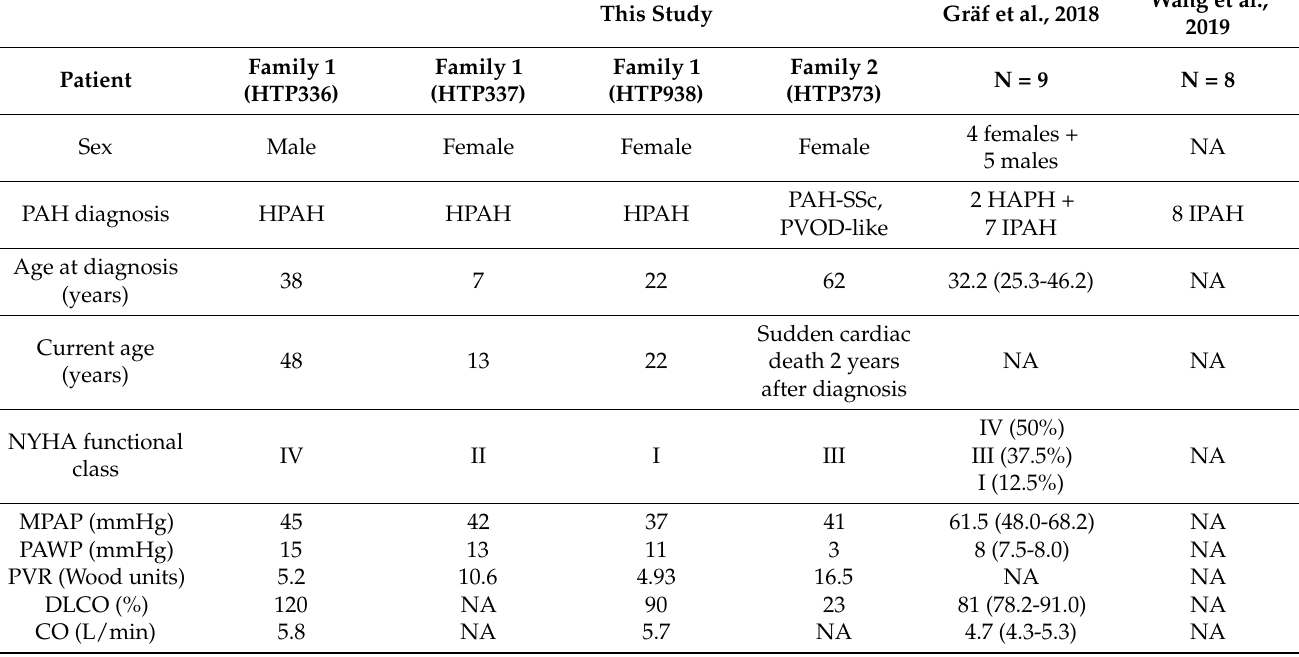
Table 1. Clinical information of PAH patients with AQP1 variants. Clinical data from Gräf et al. and Wang et al. are estimated as the mean from the cases described